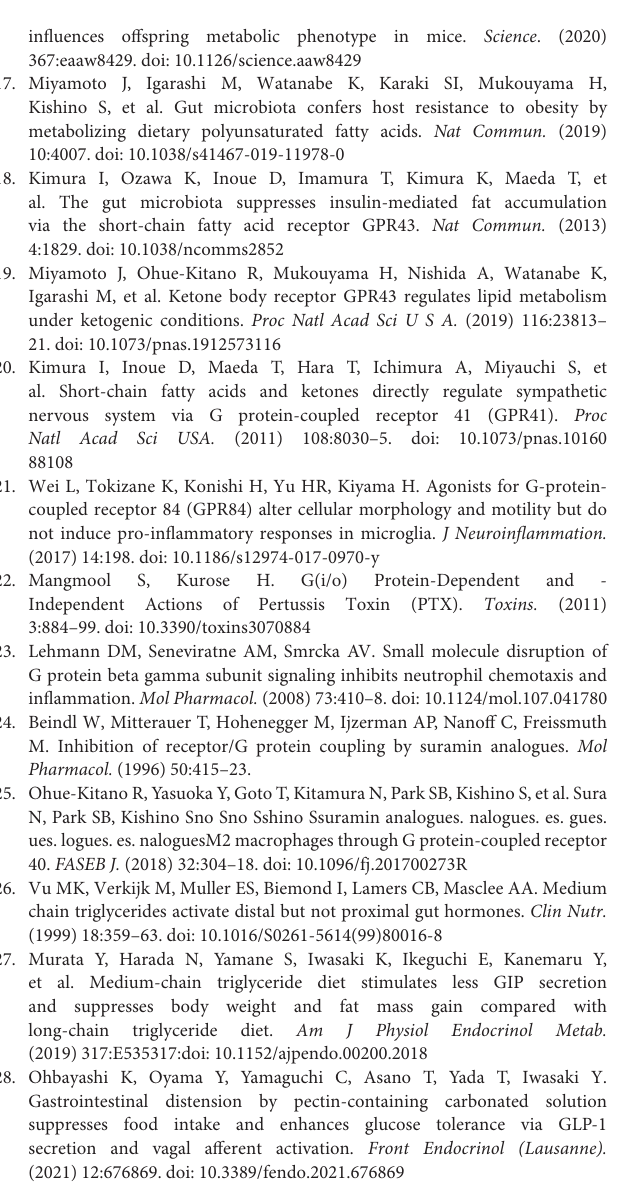
Supplementary Figure 1 | Plasma medium-chain fatty acids (MCFAs) and ketone body levels under medium-chain triglycerides (MCTs) diet-fed condition. (A) MCFAs (C8:0, C10:0, and C12:0) levels (n = 5–8) and (B) ketone body levels (n = 5–6) in the plasma of Lard or MCT diet-fed mice for 5 weeks. Samples collected after fasting for 5 h were measured by liquid chromatography/mass spectrometry (LC/MS). Dunnett’s test; ∗∗ P < 0.01, compared with Lard-diet. All data are presented as the mean ± standard error of mean (SEM). Lard, Lard diet; TriC8, octanoate (C8:0) triglyceride diet; TriC10, decanoate (C10:0) triglyceride diet; TriC12, dodecanoate (C12:0) triglyceride diet.